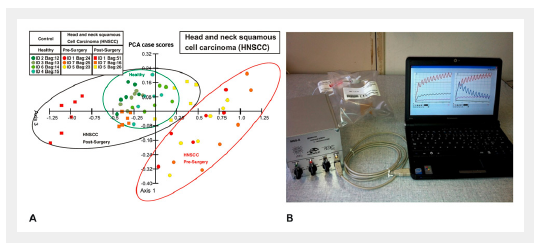
(A) Principal Component Analysis plot showing three distinct clusters (indicated with ellipses) that represent healthy control persons, head and neck squamous cell carcinoma (HNSCC) patients before surgery and HNSCC patients after surgery, i.e. after removal of the tumour by surgery. The points of the HNSCC patients after surgery are at a similar location in the PCA plot as those from the healthy persons and differ clearly from the points of the HNSCC patients before surgery, indicating that the removal of the tumour has been successful. (B) Portable USB-powered setup for mobile characterisation of patients' breath samples using polymer-coated membrane surface stress sensors. From left to right: Measurement system containing chamber with piezo membrane sensor array and pumps for aspiration of sample; breath sample bags; netbook with operating and analysis